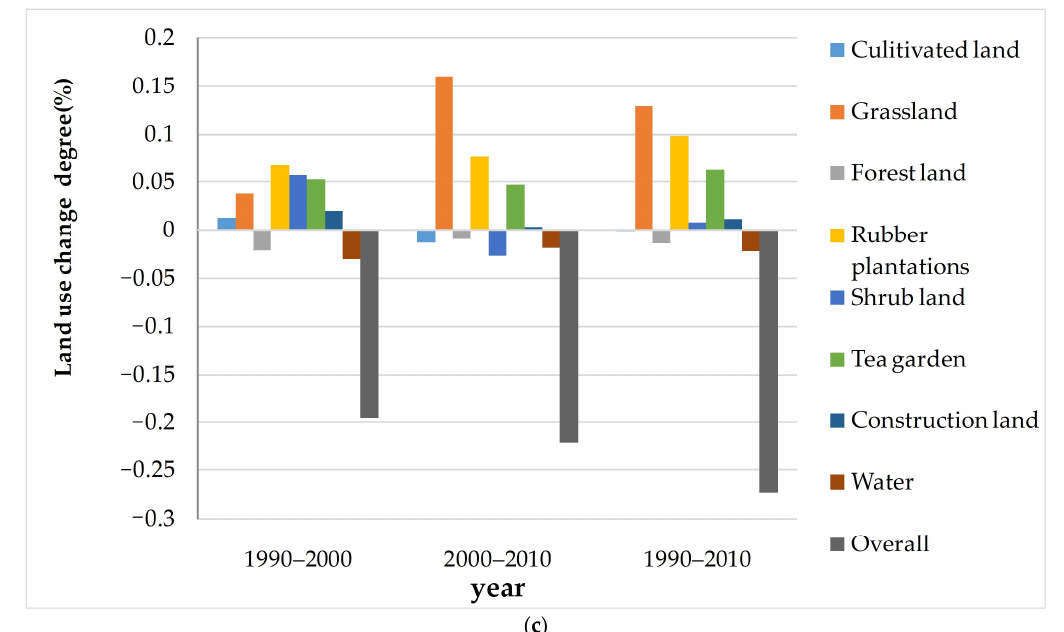
Figure 4. ( a )Land use areas in 1990, 2000, and 2010, ( b ) changes in land use type, and ( c ) land use change degree in Xishuangbanna between 1990 to 2000, 2000 to 2010, and 1990 to 2010.